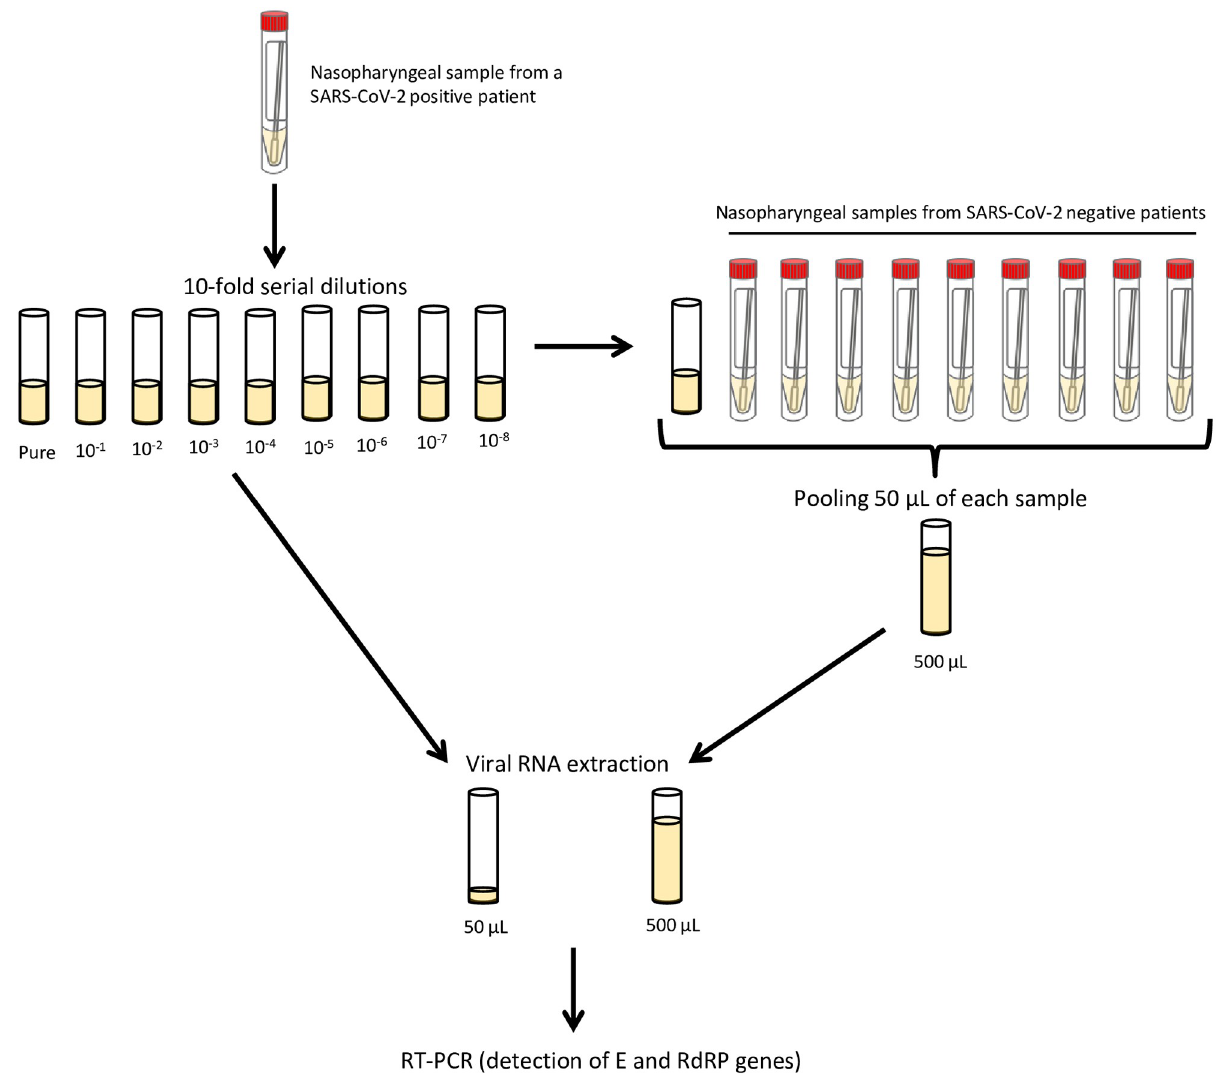
Fig 2. Protocol for the evaluation of the pooling